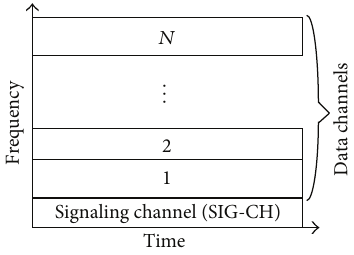
Figure 2: Uplink channel partition in frequency domain.